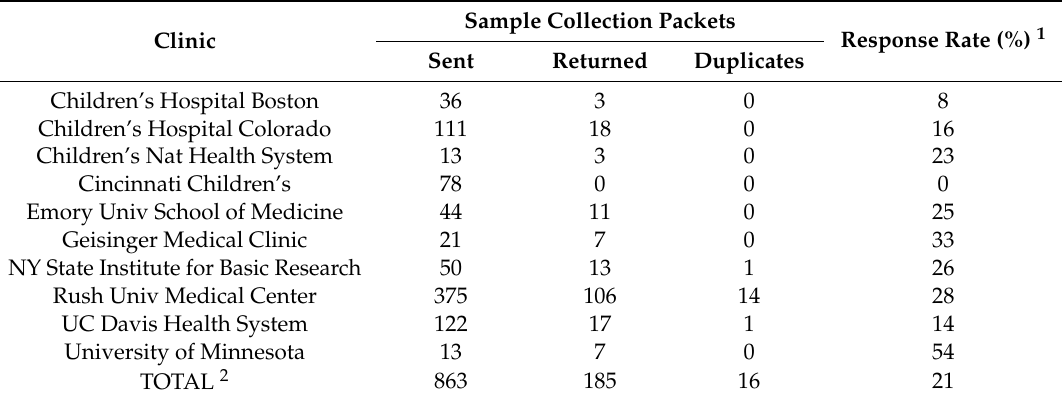
Table 1. Clinic Participation Phase